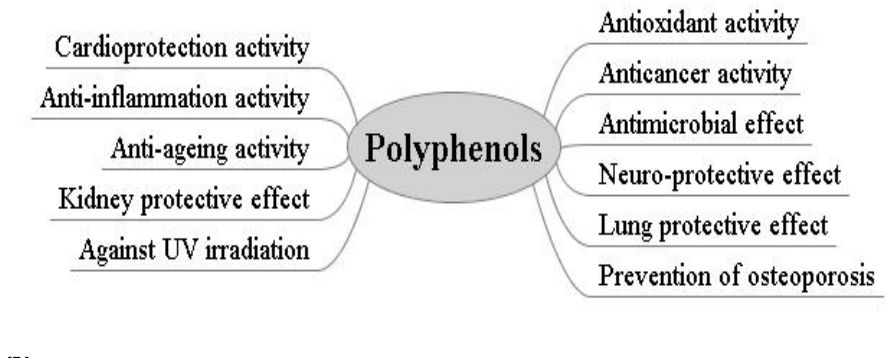
Figure 2. Some bioactivities of natural